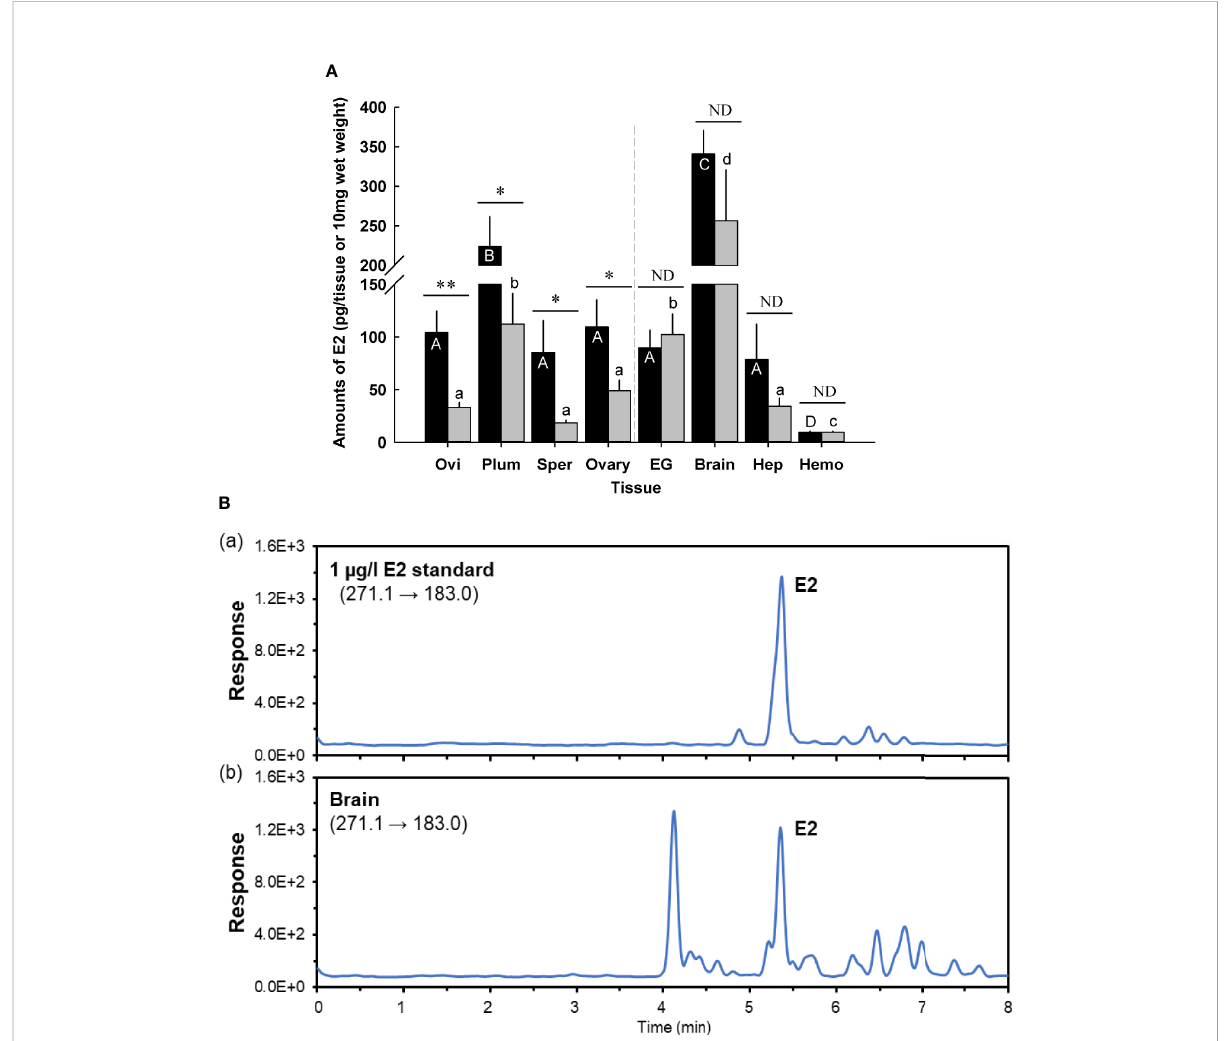
FIGURE 1 (A) Amounts of 17 b -estradiol (E2) in prepuberty female C. sapidus at early premolt stage (black bar) and late premolt stage (grey bar) based on ELISA analysis. Immature ovaries are examined. Results are presented as the mean ± 1SE pg/EG, brain or 10 mg wet weight ( n = 5). * p < 0.05; ** p < 0.01; nd, no difference. Means within group followed by different letters were different p < 0.05. Ovi, ovigerous setae; Plum, plumose setae; Sper, spermathecae; EG eyestalk ganglia; Hep, hepatopancreas and Hemo, hemolymph. (B) Representative LC-MS/MS chromatograms of E2 in (B.a) a 1 m g/l standard, (B.b) extract from the brains (prepuberty female). E2 was con fi rmed to be present in the brain, but the measured concentration was below the method quantitation